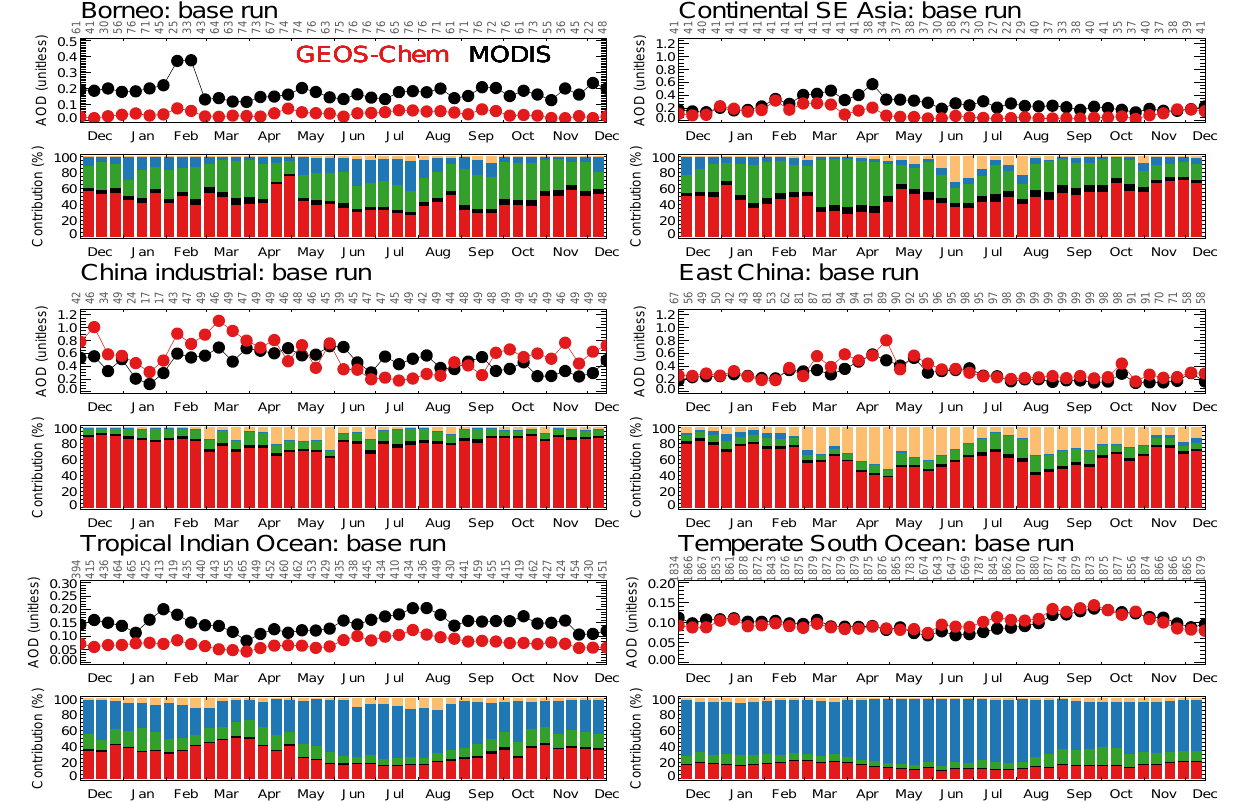
Fig. 6. MODIS and GEOS-Chem model AOD [unitless] from December 2007–December 2008, and the model source contributions to the AOD, for Borneo, Continental Southeast Asia, Industrial China, East China, Tropical Indian Ocean, and the Temperate southern ocean; the colour key for the source contribution is given at the bottom of the